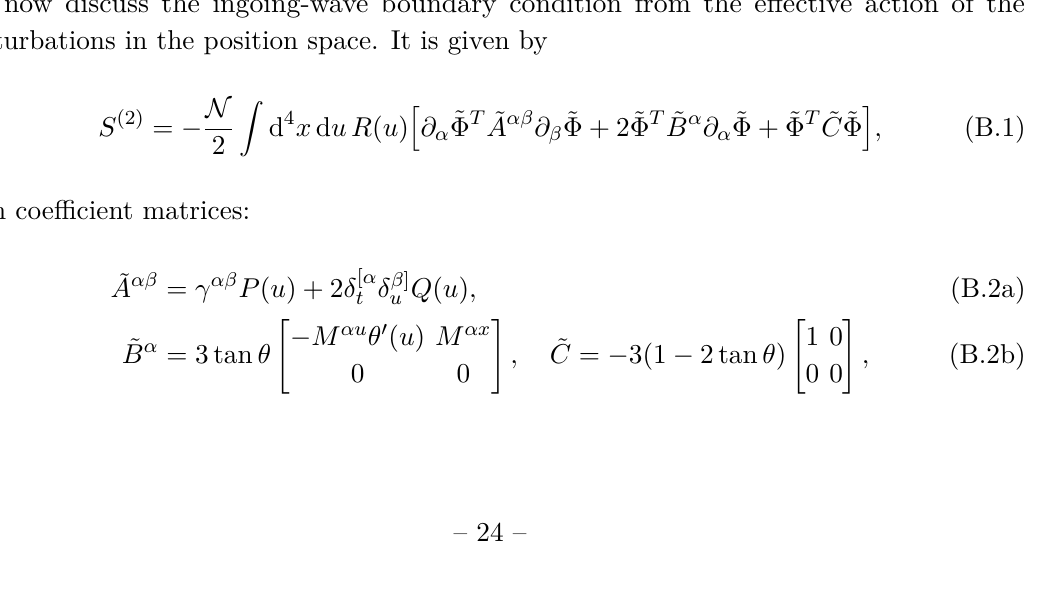
Figure 18 . (left) J/m 3 vs ω I /m , (right) k ⊥ method and the relaxation